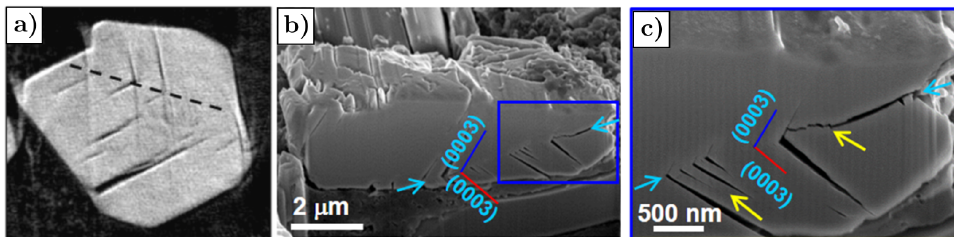
Figure 31. Cracking along the twin boundary. ( a ) Reconstructed image from X-ray nano-tomography reprinted from [137]. ( b , c ) SEM images of a cross-section of LCO particles (milled with FIB), showing cracks originating from twin boundary and their planes direction. Reprinted with permission by Elsevier from [136], Copyright